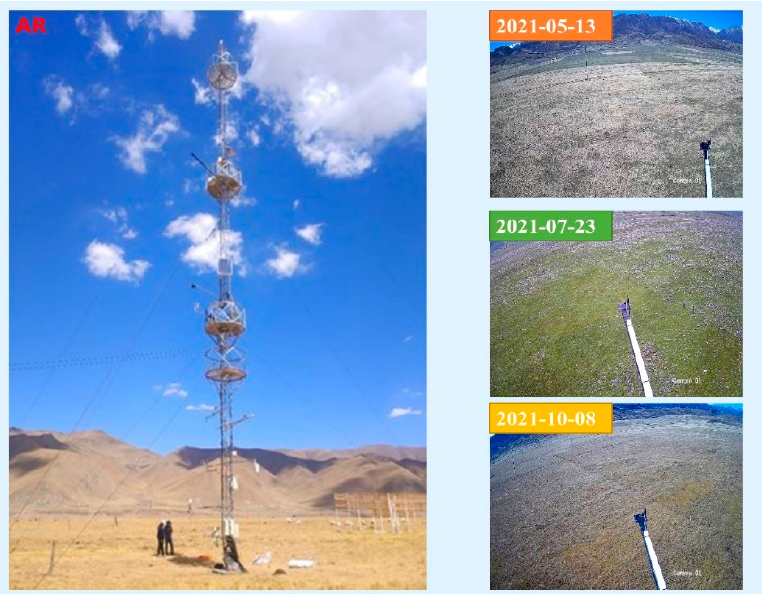
Figure 1. AR’s observation tower and pictures of the alpine meadow in spring, summer, and autumn captured by the camera mounted above the